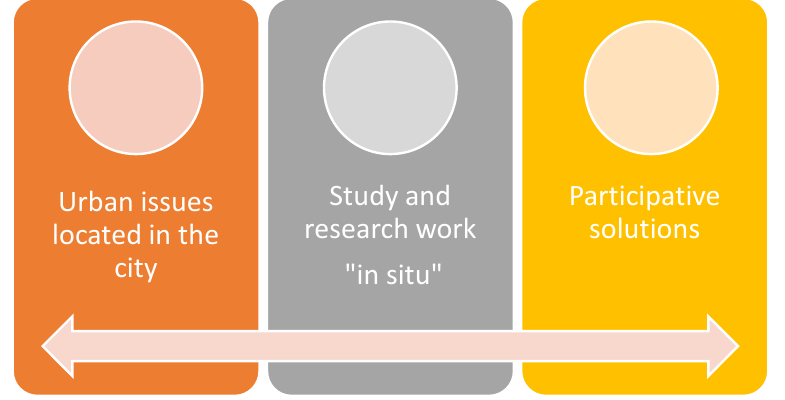
Figure 4. Principles of the Project “We Propose!” Source: [36].